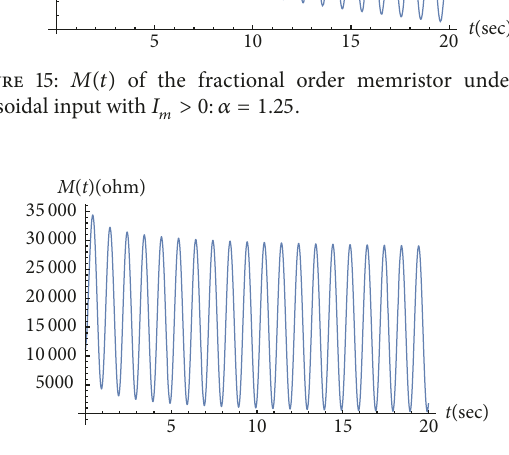
Figure 16: 𝑀(𝑡) of the fractional order memristor under the sinusoidal input with 𝐼 𝑚 < 0: 𝛼 = 0.75 .